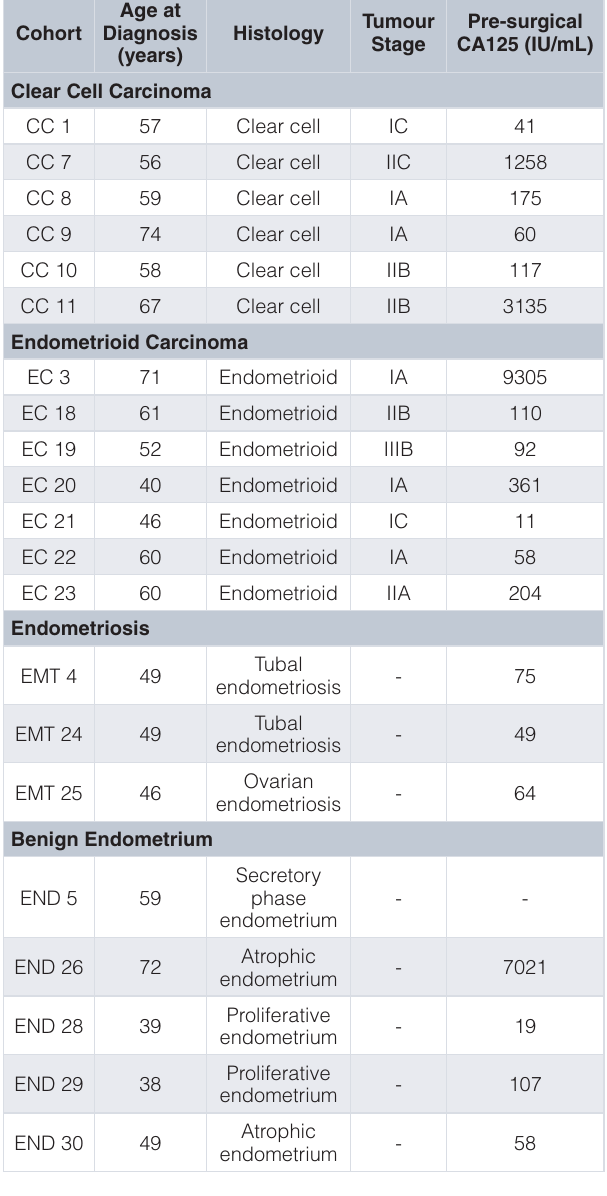
Table 1. Clinical and histological characteristics of the gynecological patients. Age at Cohort Diagnosis (years)